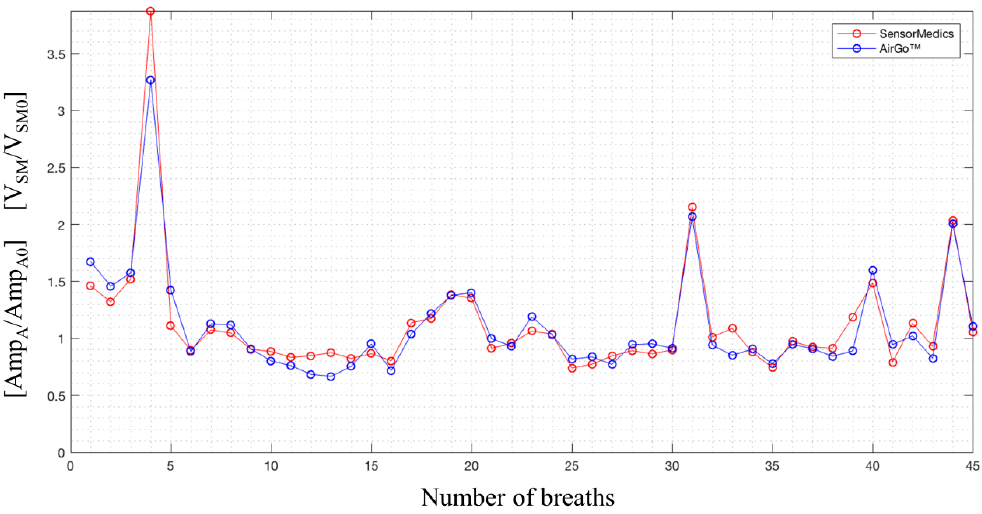
Figure 6. SensorMedics’ normalized volumes and Airgo™’s normalized amplitudes synchronized, standing position, healthy female subject (38 years old, 165 cm, 52 kg).